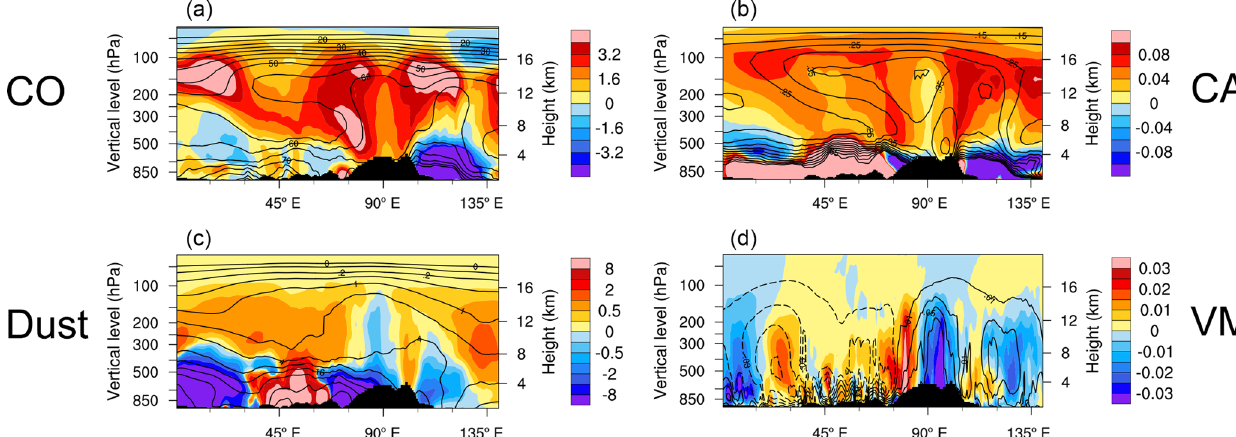
Figure 5. Longitude–height cross sections (0–140 ◦ E) of (a) CO (ppbv), (b) CA (ppbm), (c) dust (ppbm) and (d) vertical motion (Pas − 1 ) anomalies between strong and weak monsoon years (“strong” minus “weak”) averaged over the southern portion of the AMA (25–35 ◦ N) during July–August, superimposed with the climatological mean of weak monsoon years (black contours). For vertical motions in (d) , solid (dashed) contours indicate ascent